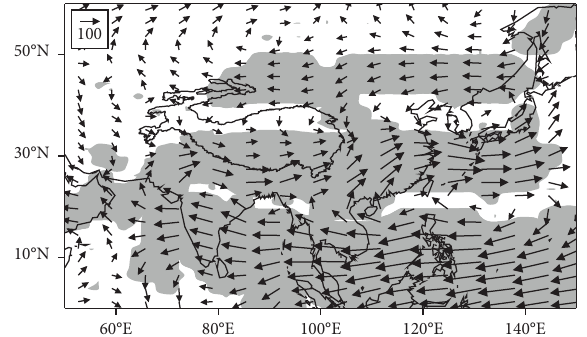
Figure 10: Diference synthetic feld of water vapor transport fux from 1000 to 100hPa of strong AHS/weak westerly-monsoon year and weak AHS/strong westerly-monsoon year (unit: kg s − 1 m − 1 , shadow indicates passing 95% reliability